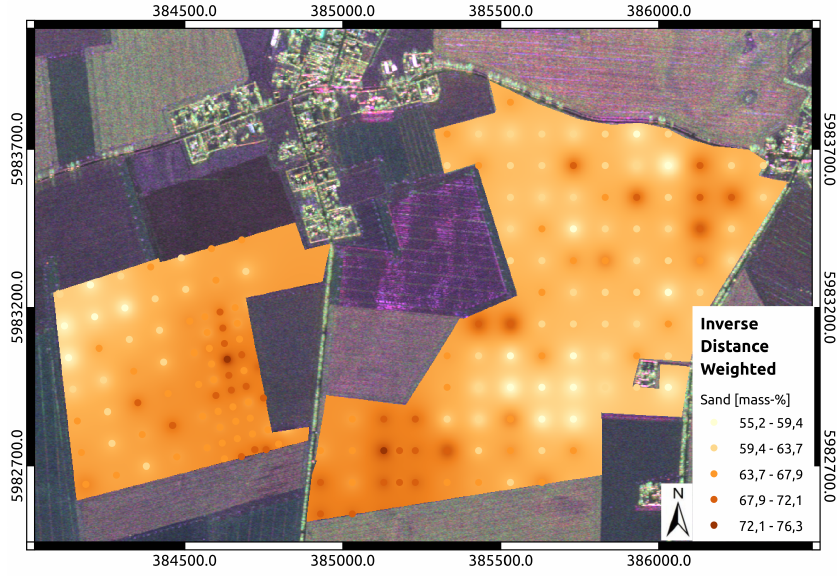
Figure 14. Spatial interpolated soil map for the texture class sand based on the Inverse-Distance- Weighted (IDW) approach. Circles display the sample locations and colors are scaled in the same color as background sand